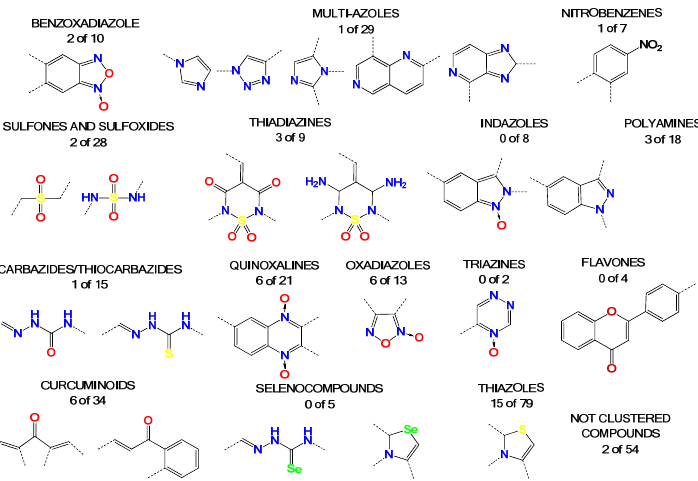
Figure 2. Representation of the compound families used in this work. There are 15 clustered families and 54 compounds with high diversity of structures. The numbers below the families’ names are the molecules with inhibitory effects in our assembly assay versus the total molecules of the family that we tested (see below). For example, we identified two molecules of the benzoxadiazole family which inhibit in vitro assembly out of the 10 molecules tested.